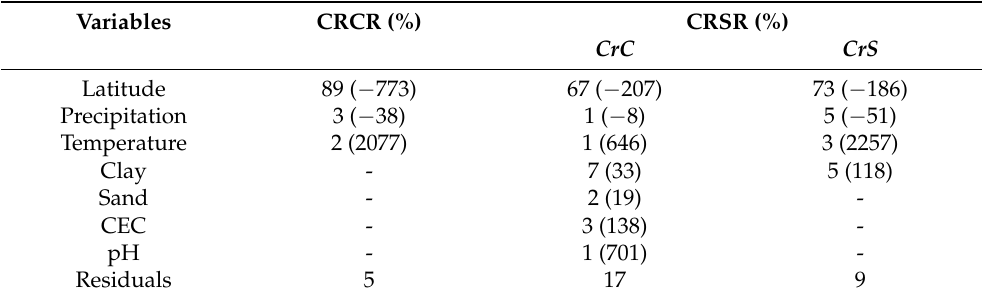
Table 3. Quantifying the variability explained (%) by various factors in cereal rye biomass under different crop rotations.